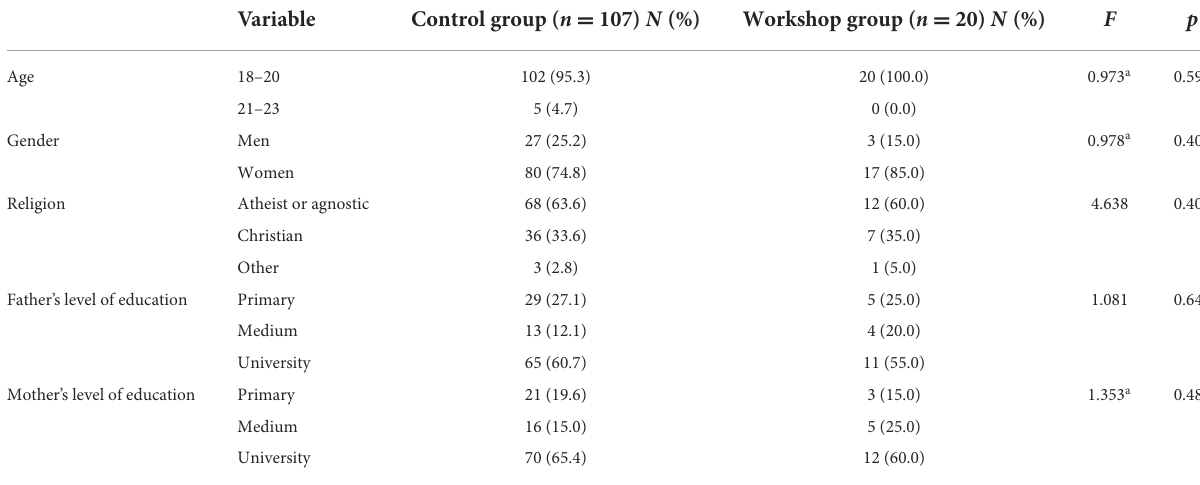
TABLE 1 Sociodemographic characteristics of the sample at baseline by group.